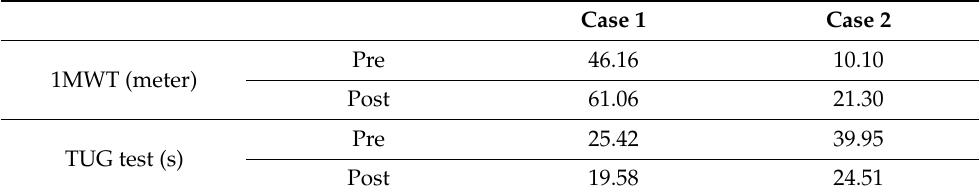
Table 5. Changes in one-minute walk test and Timed Up and Go test after